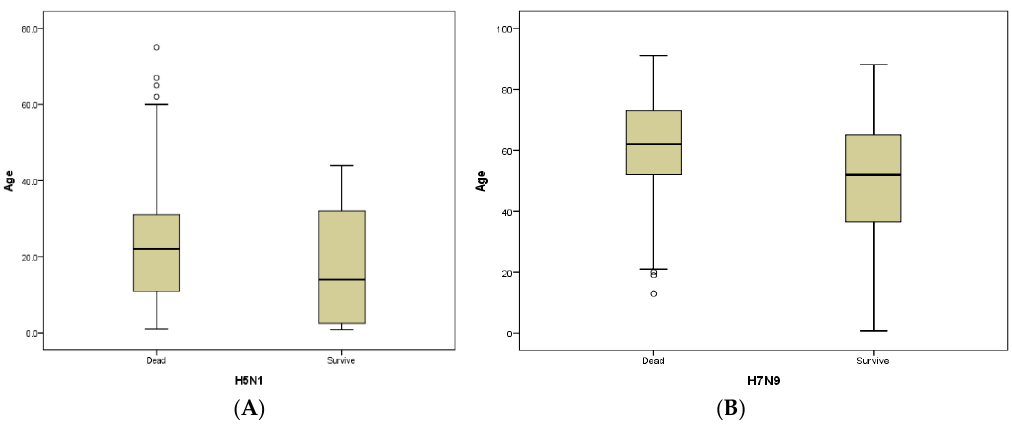
Figure 3. A detailed boxplot figure for the age of the fatal and survival cases with highly pathogenic avian influenza viruses H5N1 and low pathogenicity avian influenza viruses H7N9 virus dates of onset from 1 January 1 1997 to 30 November, 2016. ( A ) The age distribution of highly pathogenic avian influenza A (H5N1): survivors (N = 151) and deaths (N = 293). ( B ) The age distribution of low pathogenic avian influenza A (H7N9): survivors (N = 391) and deaths (N = 265).